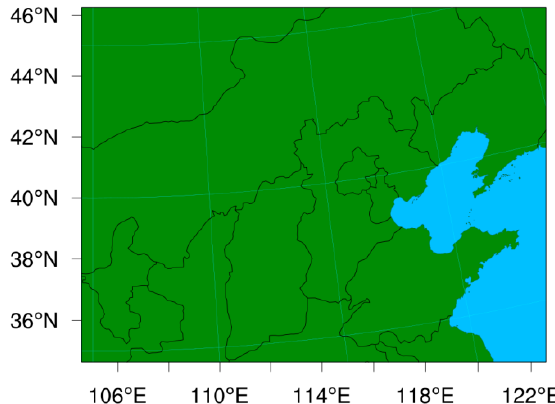
Figure 1 . The model domain configuration for the North China REPS. Figure 1. The model domain configuration for the North China